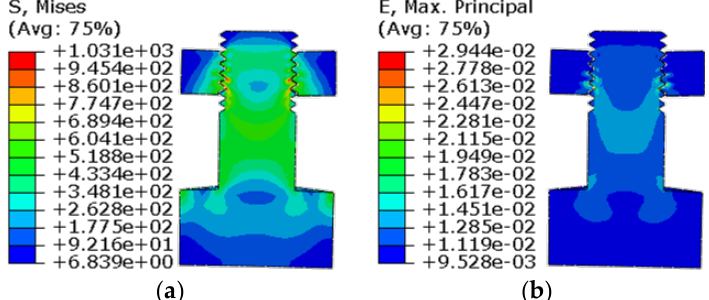
Figure 12. Von Mises equivalent stress and maximum principal strain contours of the bolt and nut at 650 °C: ( a ) Von Mises equivalent stress; ( b ) maximum principal strain.